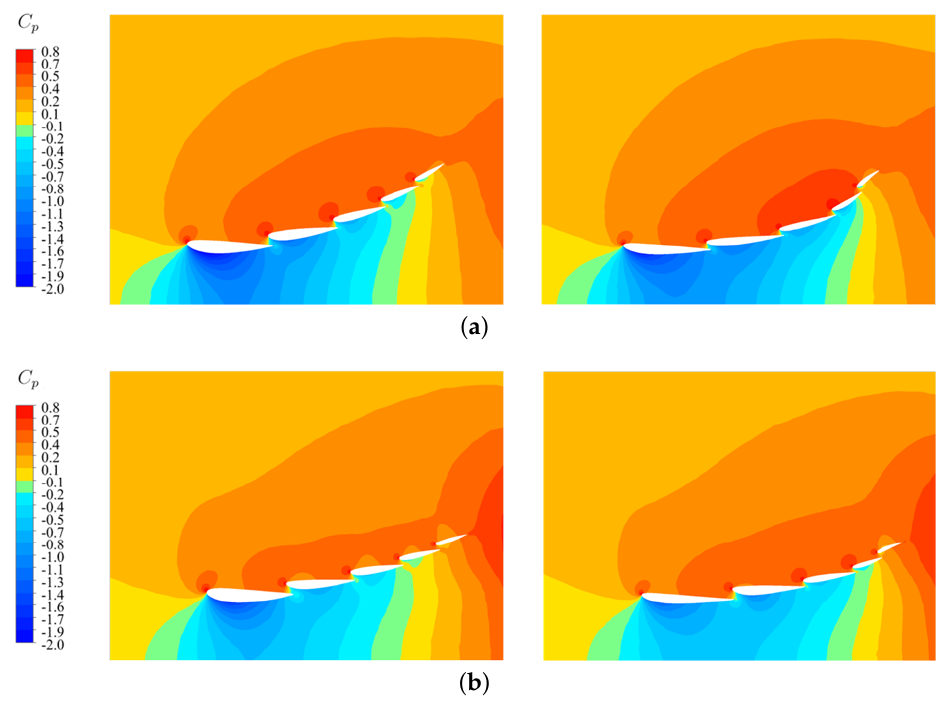
Figure 10. C p comparison between parametric ( left ) and hybrid ( right ) optimal front wings for